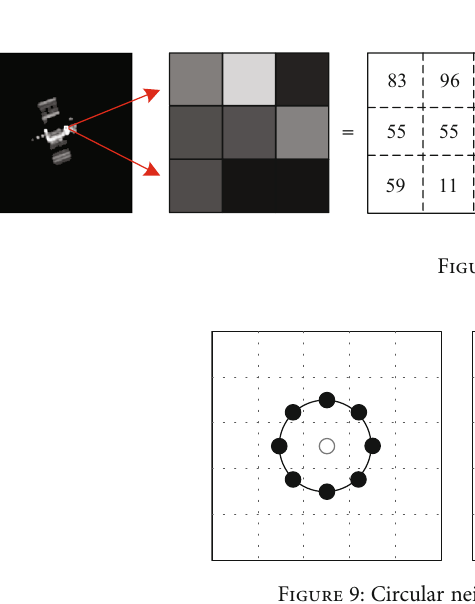
Figure 7: Flowchart for extracting the trace feature of the ISAR image.